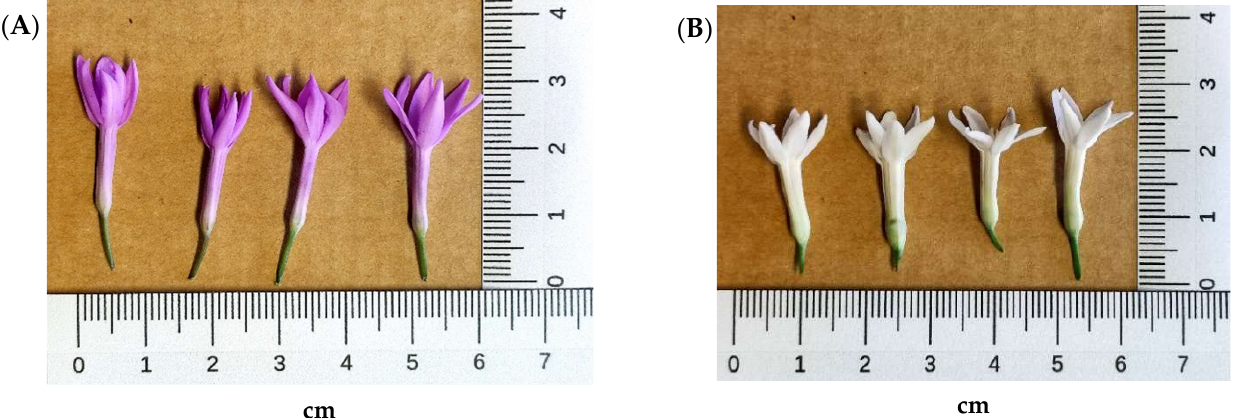
Figure 1. Purple and white flowers of T. violacea from the two varieties. ( A ): var. ‘Violacea’: ( B ): var. ‘Alba’.